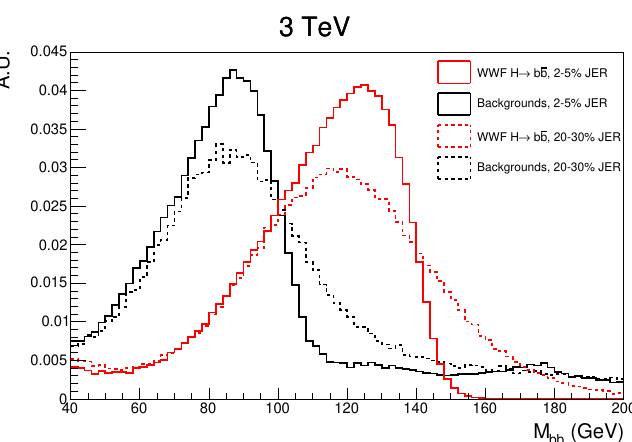
¯ b pairs for the combined VBF signal (red)